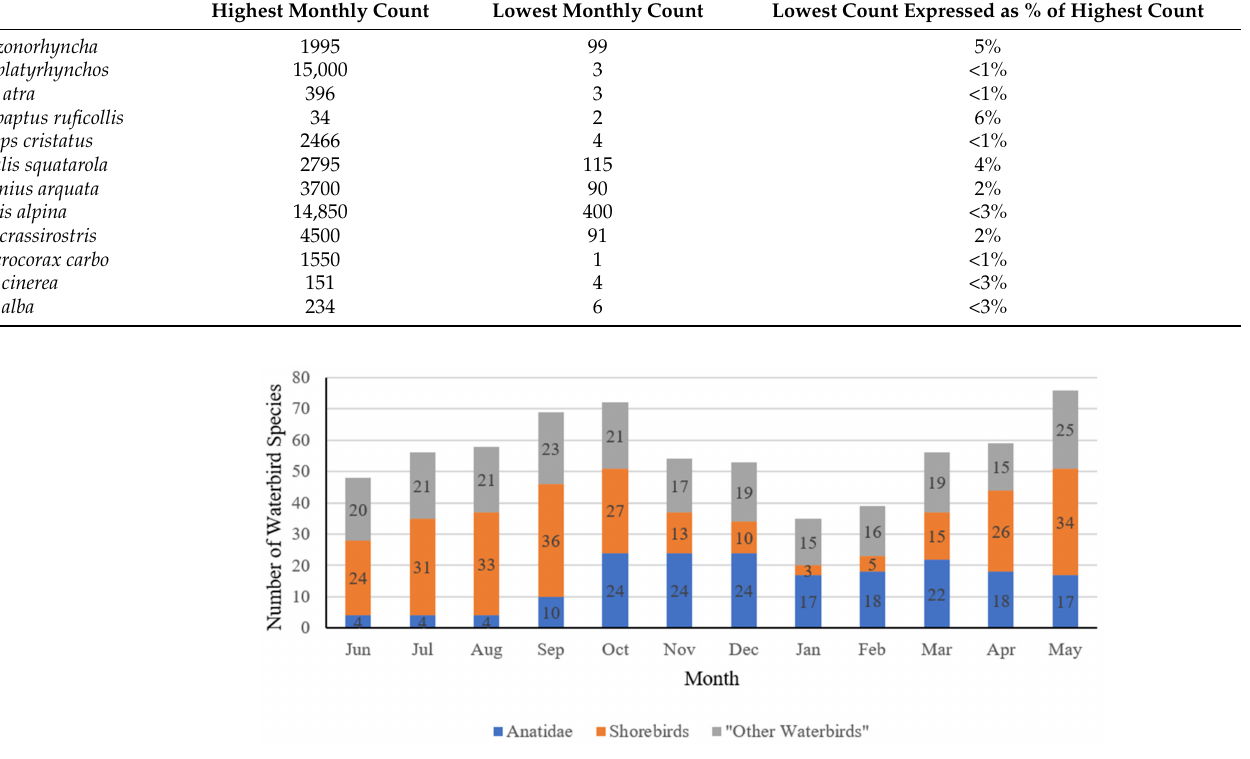
Figure 3. Number of waterbird species recorded during the Project Surveys by month and main category at the Hwaseong Wetlands FNS in 2020 and